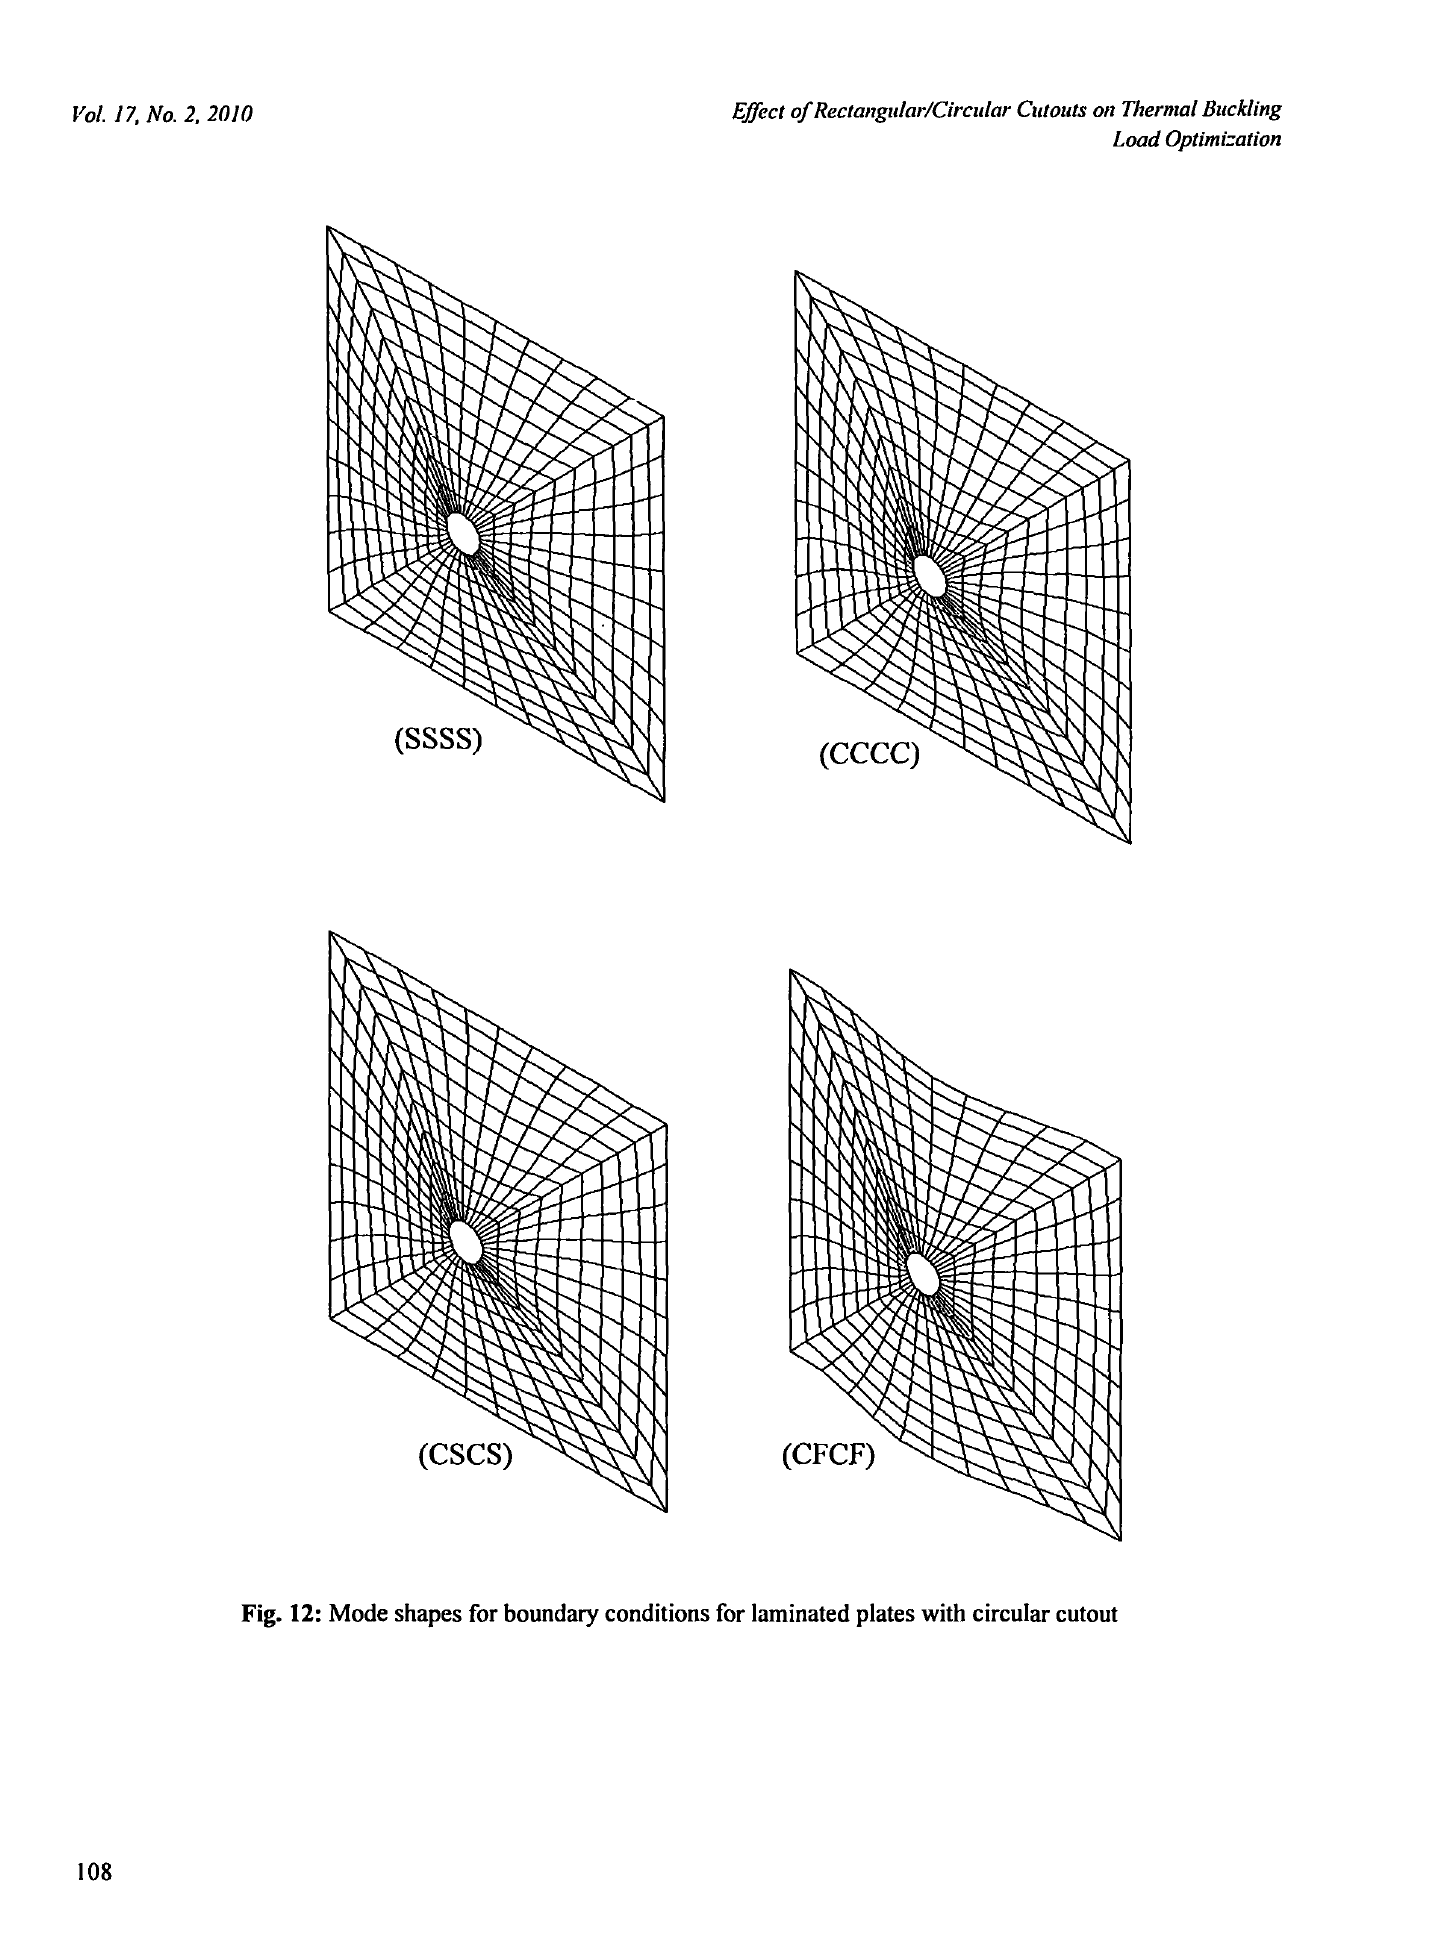
Fig. 12: Mode shapes for boundary conditions for laminated plates with circular cutout